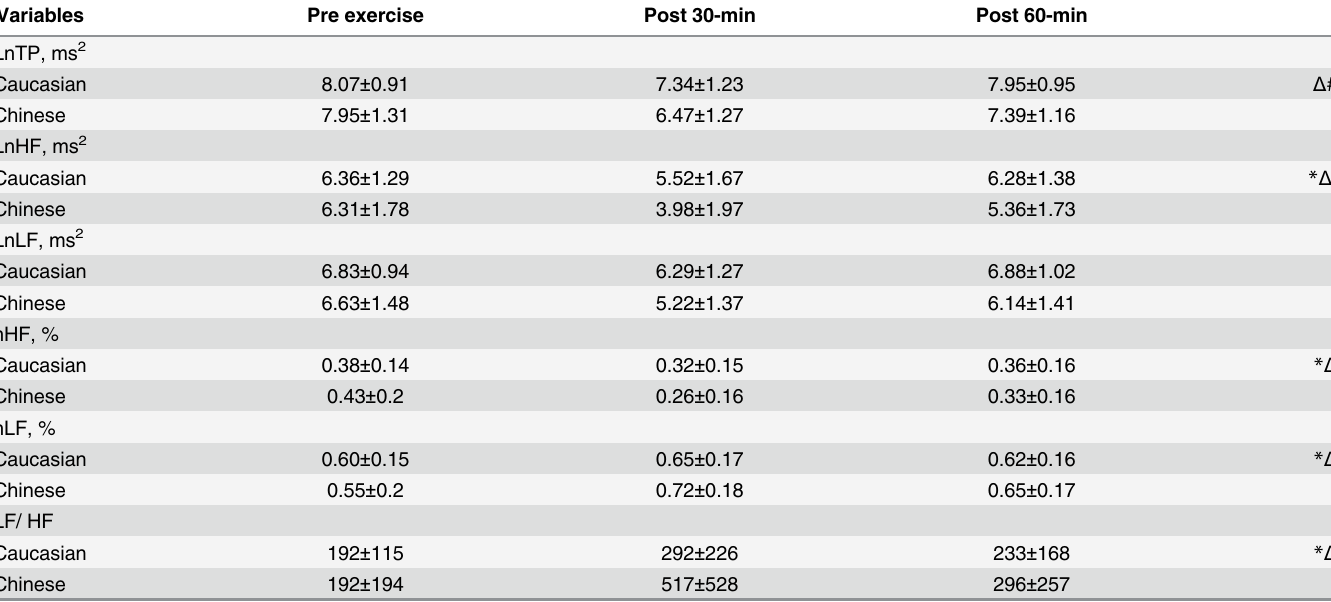
Table 2. Frequency domain measures of heart rate variability at baseline and recovery following exercise in Caucasian and